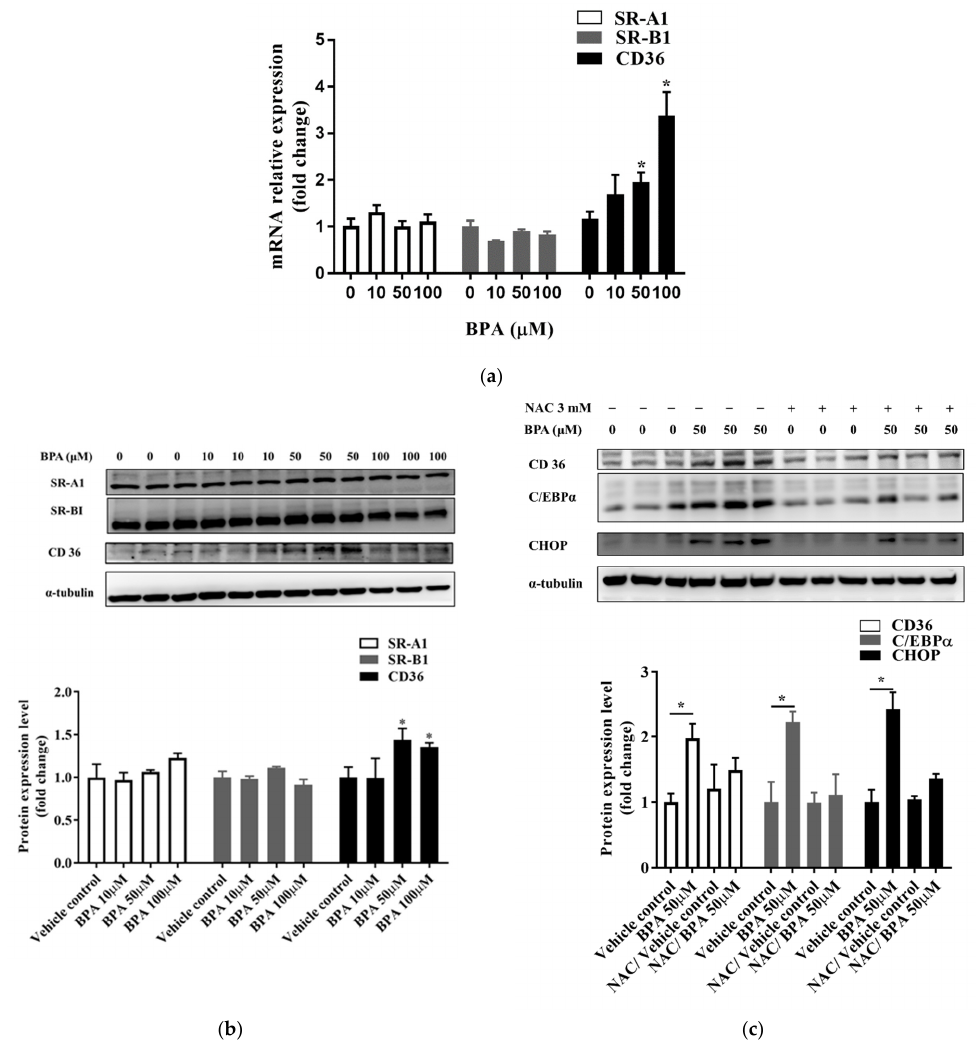
Figure 4. NAC inhibited the C/EBP α and CD36 lipid-related endocytosis pathway, which was upregulated by BPA exposure. Cells were treated with the indicated concentrations of BPA for 24 h. The ( a ) mRNA and ( b ) protein expression levels of CD36, SR-A1, and SR-B1 were assessed using RT-qPCR and immunoblotting, respectively. ( c ) To determine whether BPA exposure increases CD36 expression by increasing ROS production, cells were pretreated with or without NAC (3 mM) for 1 h. The protein expression levels of CD36, C/EBP α , and CHOP were determined using im- munoblotting. Protein expression levels were normalized to α -tubulin. Data are shown as the mean ± SD of three independent experiments. * p < 0.05 vs. vehicle control group. 3.5. BPA Enhanced Hepatic Pathological Progression in Mice We investigated the effect of BPA exposure on the progression of NAFLD in mice administered a high-fat diet. The average daily food and water intake of mice in the ND, HFCCD, BPA + HFCCD, and NAC + BPA + HFCCD groups were 2.9, 2.6, 2.4, and 2.6 g,